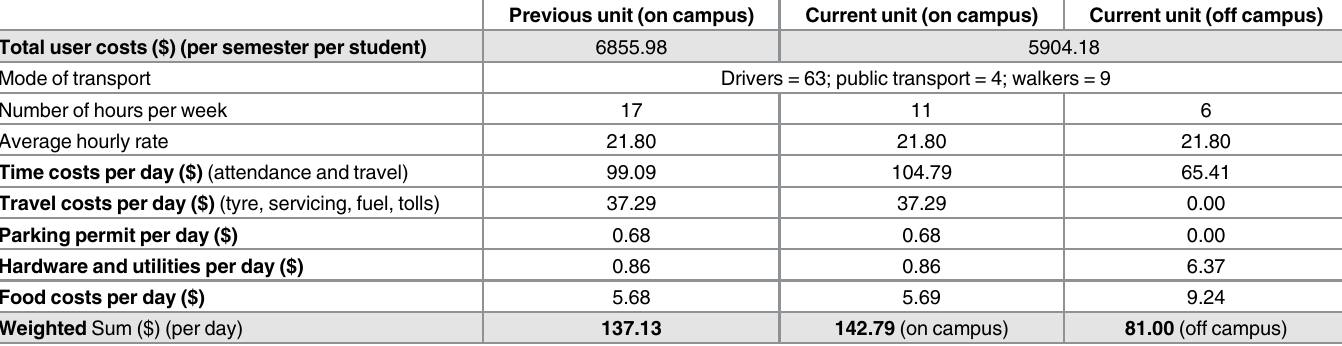
Table 1. Estimating User